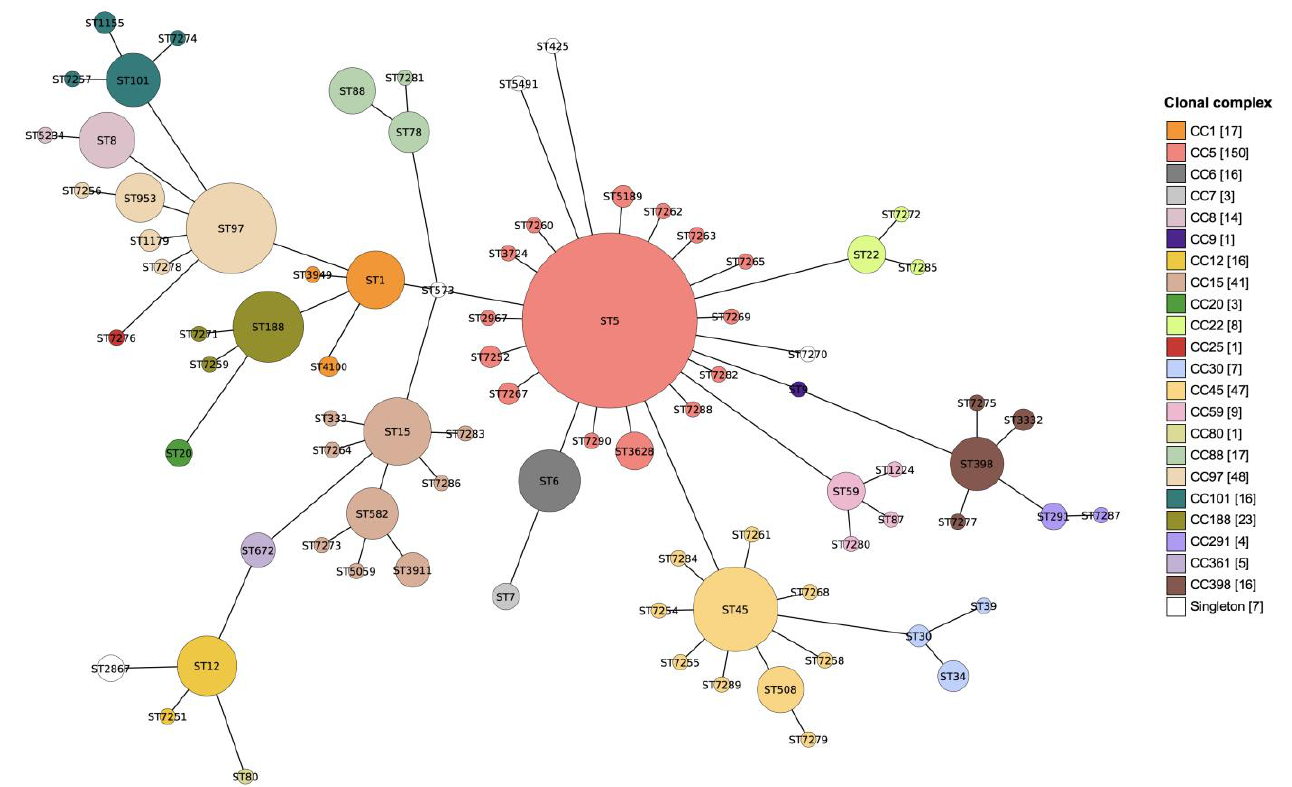
Figure 1. Minimal spanning tree showing distribution of MLST sequence type (ST) and clonal complex (CC). Each circle represents an ST and the size of each circle is proportional to the number of isolates described by the ST. The length of the line connecting two circles is proportional to the number of MLST loci by which the two STs differ. Each circle is colored by CC and the number of isolates in each CC is given in the color legend.